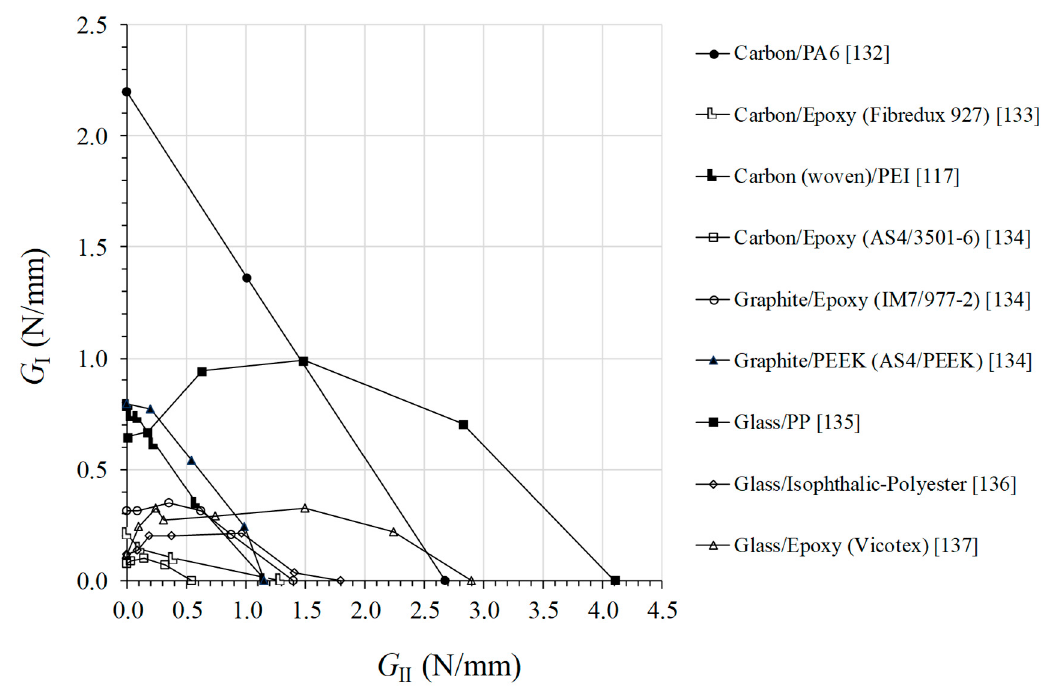
Figure 7. Comparison of critical energy release rate of unidirectional composites under mixed mode loading. Filled and hollow marks stand for thermoplastic and thermoset based composites, respectively [117,132–137].